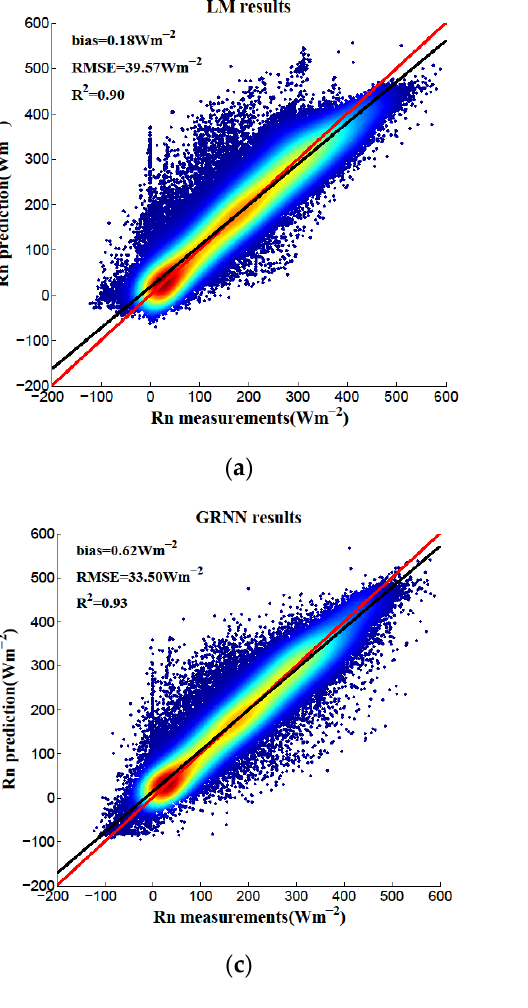
Figure 3. The scatterplots of the comparison results of the predictions from the four models: ( a ) LM; ( b ) MARS; ( c ) GRNN; ( d ) SVR. Table 4. The statistic results of the four models.